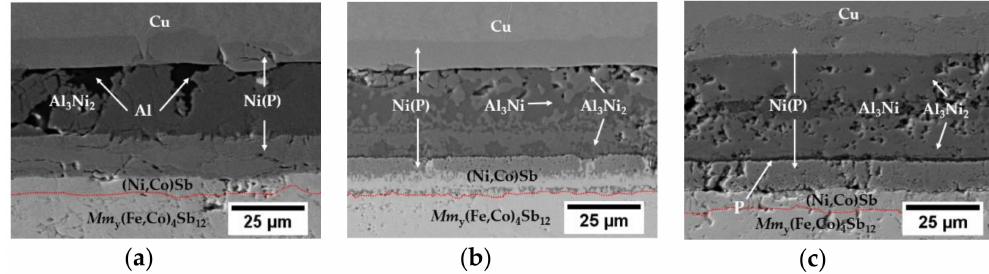
Figure 3. Cross-sectional microstructure of the skutterudite–interconnect interfaces bonded at ( a ) 585 ◦ C; ( b ) 660 ◦ C and ( c ) 660 ◦ C and isothermally aged at 450 ◦ C for 96 h, under flowing Ar, with the Co-Ni-Sb reaction layer marked in red. The high magnification image of Ni(P)–Al 3 Ni 2 interface can be found in the Supplementary Materials (Figure